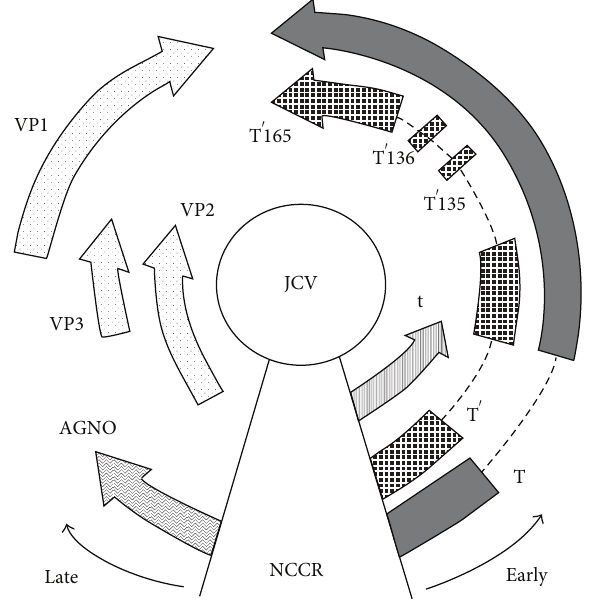
Figure 1: Schematic representation of the JCV genome organi- zation. The circular, double-stranded DNA genome is ∼ 5.2 kb in size and is divided into the early coding region and the late coding region, transcribed in opposite directions from a common noncoding control region (NCCR). Early genes include large T antigen (T-Ag), small t antigen (t-Ag), T 󸀠 135, T 󸀠 136, and T 󸀠 165. Late genes include VP1, VP2, VP3, and